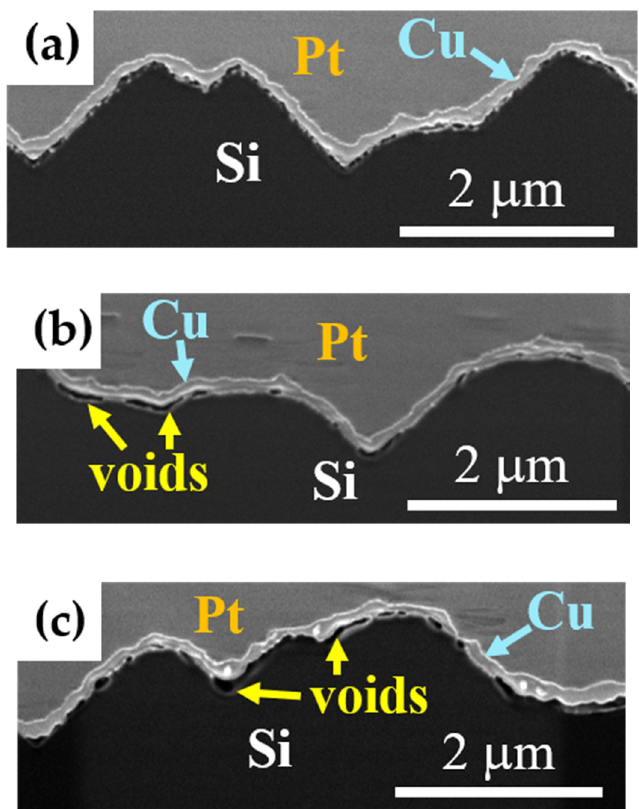
Figure 2. The cross-sectional views of SEM for the Cu/AZO/Si samples were annealed at ( a ) 400, ( b ) 600, and ( c ) 800 °C.